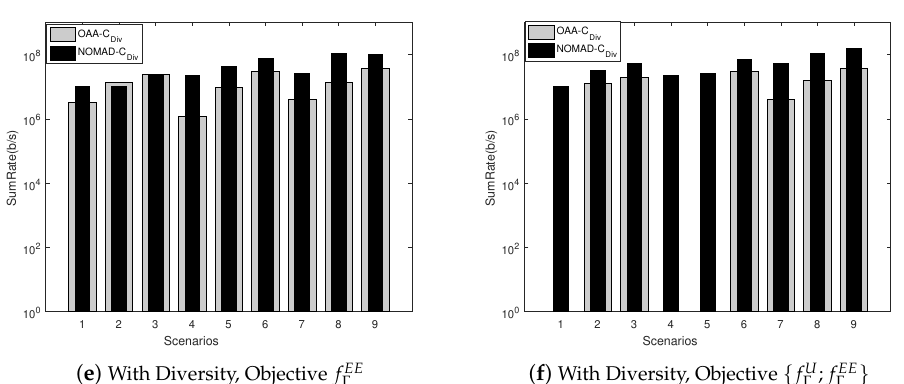
Figure 7. Sum Rate of IoT Devices/Mobile Users for various parameters. Required rate 1 Mbps, P max = 20 dbm. Scenarios are { K , R }: {1,2,3,4,5,6,7,8,9} = {(10,5),(10,10),(10,15),(20,5),(20,10),(20,15),